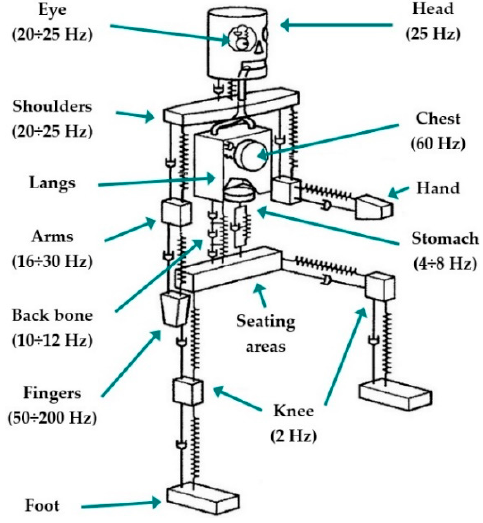
Figure 1. A dynamic model of a human body [48,49].